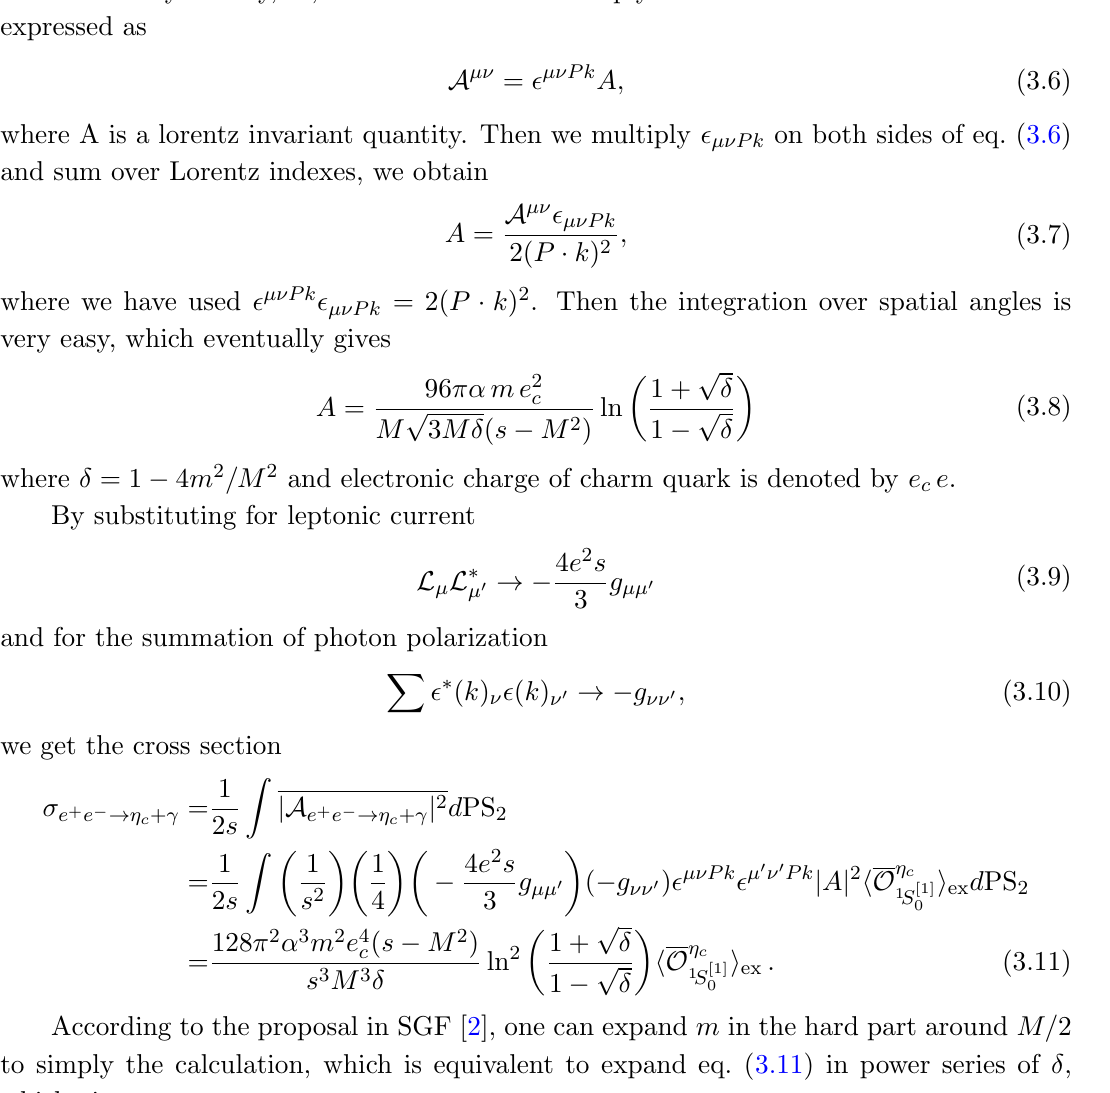
(cid:17) c + (cid:13) at leading order in (cid:11) s !